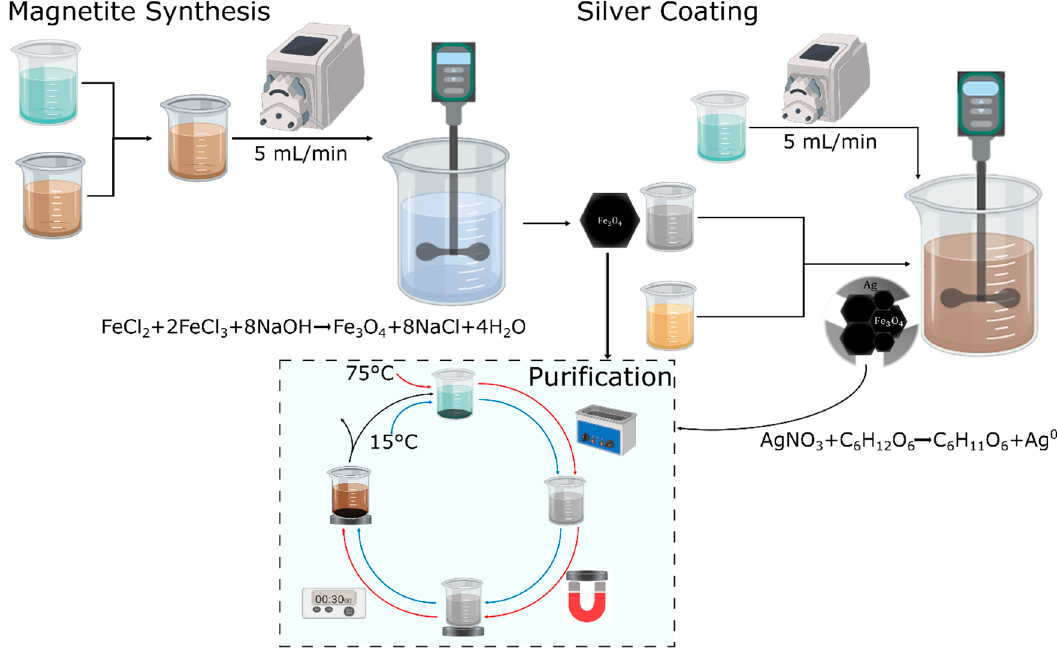
Figure 1. Schematic for the green synthesis of patchy core/shell, magnetite/silver nanoparticles. First, magnetite was synthesized using the co-precipitation method (the reaction scheme taking place is also shown). Second, the patchy silver coating was deposited by reducing silver nitrate in a honey solution (reducing agent) with the glucose present (reaction shown below). Finally, the dotted frame process represents the cleaning or purification steps with either hot (75 °C) or cold water (15 °C).